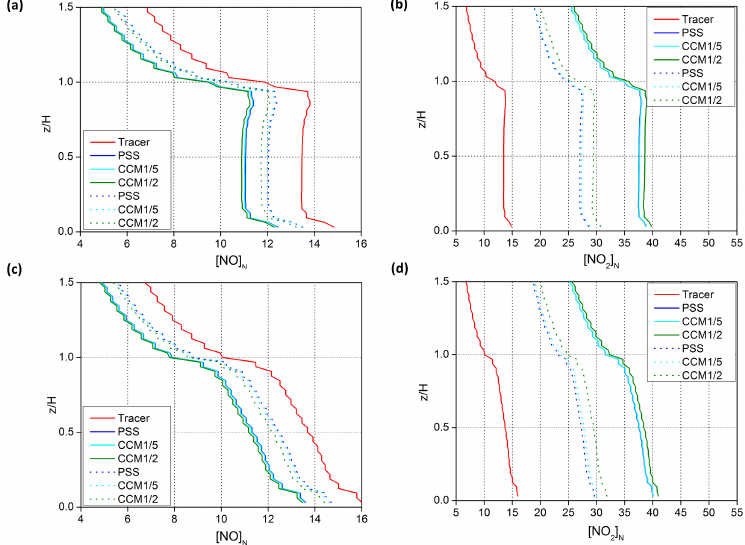
Figure 7. Vertical profiles of horizontal spatial average of [NO] N and [NO 2 ] N for all chemical scenarios in case 1 (solid line) and case 2 (dotted line) in both geometries: 2-D (a, b) and 3-D (c, d)